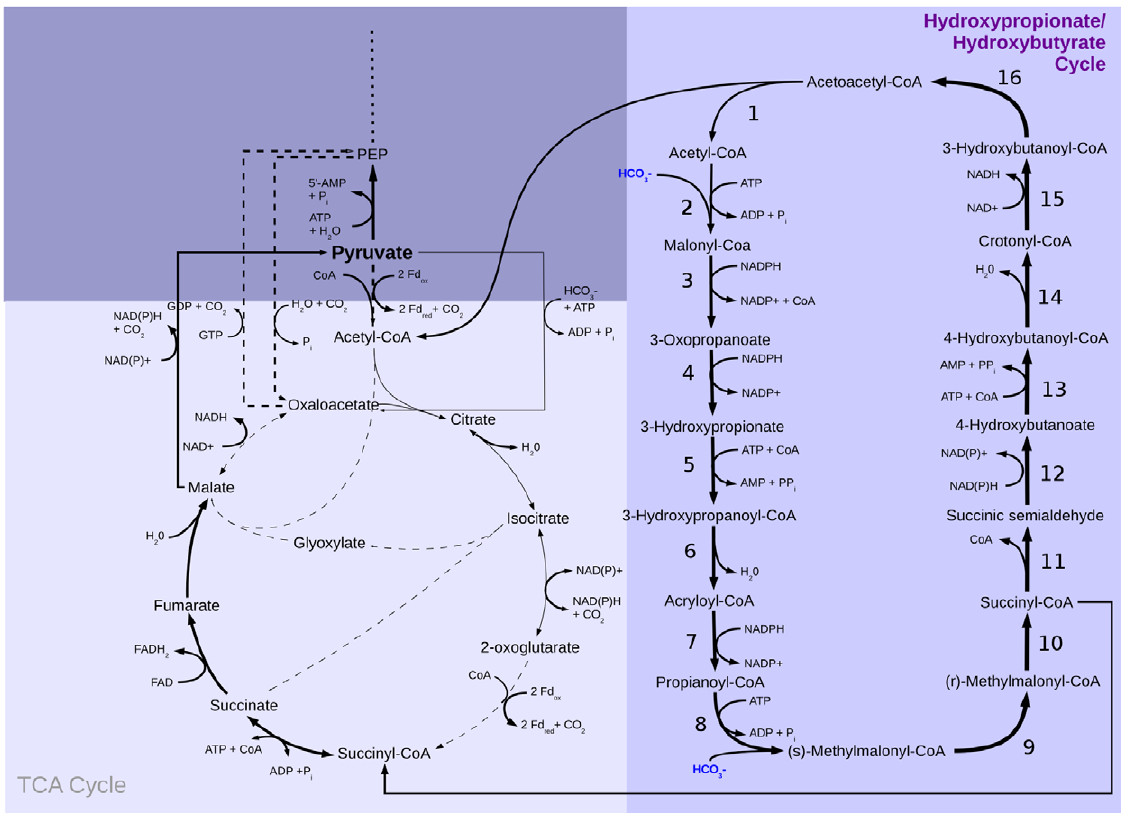
Figure 3. Hydroxypropionate-hydroxybutyrate cycle and tricarboxylic acid cycle in S.solfataricus with flux distribution for growth on HCO 3 2 . Solid arrows show the used pathways and their directions. Dashed arrows show available but not used pathways. Arrow size represents predicted flux though the pathways. Enzymes in the hydroxypropionate-hydroxybutyrate cycle are: (1) acetyl-CoA C-acetyltransferase, (2) acetyl-CoA carboxylase, (3) malonyl-CoA reductase (NADPH), (4) malonic semialdehyde reductase (NADPH), (5) 3-hydroxypropionate-CoA ligase, (6) 3- hydroxypropionyl-CoA dehydratase, (7) acryloyl-CoA reductase (NADPH), (8) propionyl-CoA carboxylase, (9) methylmalonyl-CoA epimerase, (10) methylmalonyl-CoA mutase, (11) succinyl-CoA reductase, (12) succinic semialdehyde reductase (NADPH), (13) 4-hydroxybutyrate-CoA ligase, (14) 4- hydroxybutyryl-CoA dehydratase, (15) enoyl-CoA hydratase, (16) (S)-3-hydroxybutyryl-CoA dehydrogenase (NAD + ).